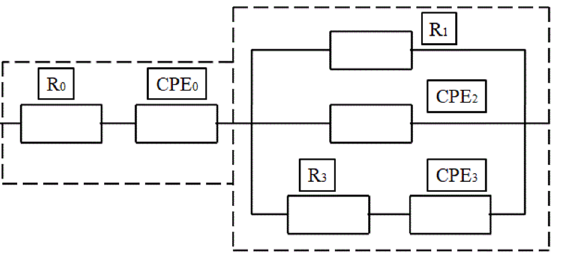
Figure 14. The circuit model for the hydration study.